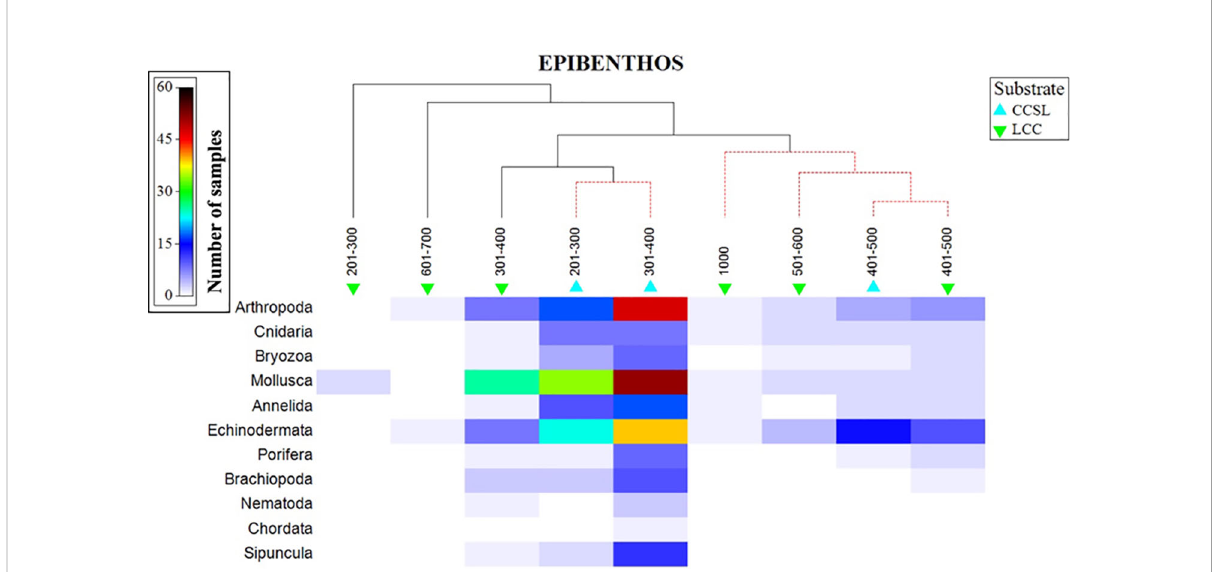
FIGURE 7 Shaded plot, superimposed with a SIMPROF cluster of the aggregated and summed Bray-Curtis resemblance matrix (square-rooted), showing the phyla represented in the depth and substrate groups.